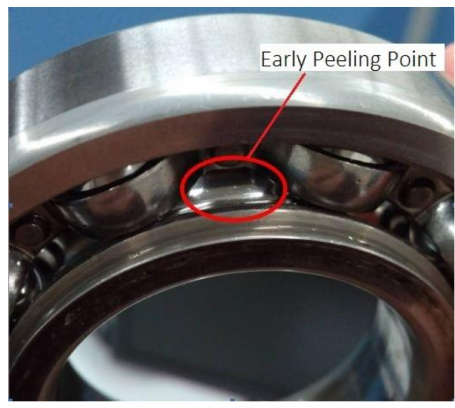
Figure 12. Early fatigue pitting failure in inner ring of bearing after running for 110 h.